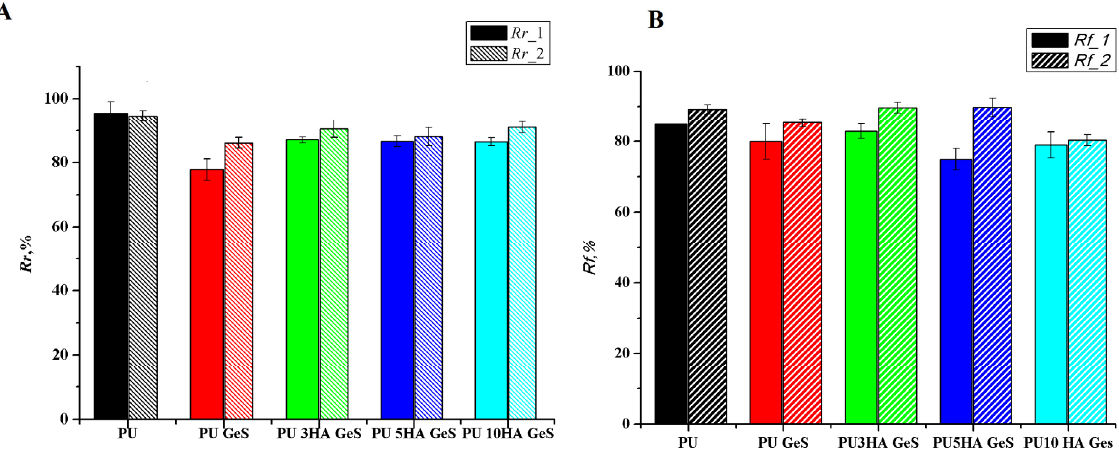
Figure 6. The shape-memory coefficients of ( A ) R r and ( B ) R f , calculated based on cyclic-